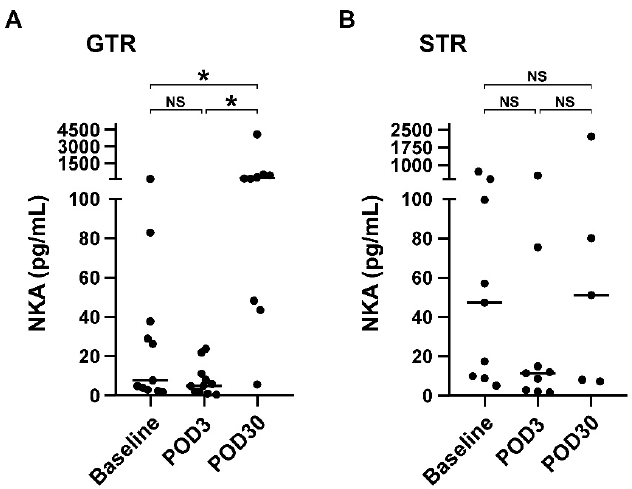
Figure 3. GTR rather than STR significantly recovered the impaired NKA at POD30. NKA of glioblastoma patients before (baseline) and after receiving GTR ( A ) or STR ( B ) on POD3 and POD30. Data were presented as scatter plot with median (solid line), and differences between groups were analyzed using two-tailed Mann-Whitney U test. * p < 0.05 was considered statistically significance between groups, while NS denotes no statistically significant difference. Abbreviation: NKA, NK cell activity; GTR, gross total resection; STR, subtotal resection; POD3, postoperative day 3; POD30, postoperative day